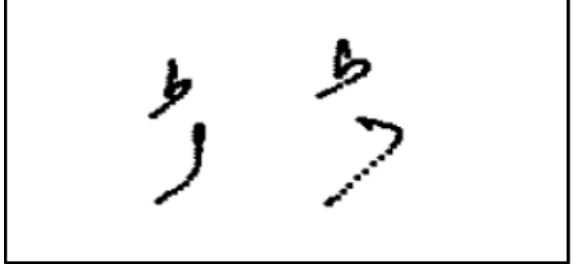
Figure 5. Urdu character “De” ( left ) and “Daal” ( right ) were repeatedly